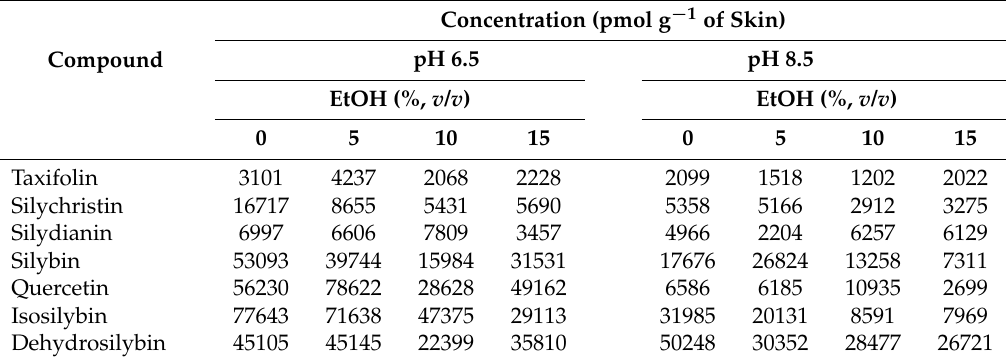
Table 3 . Skin intake of studied compounds evaluated by transdermal transport. Table 3. Skin intake of studied compounds evaluated by transdermal transport.